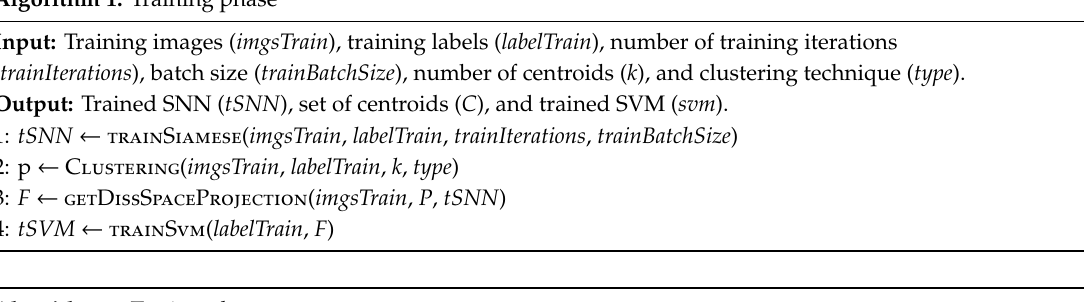
Algorithm 1. Training phase